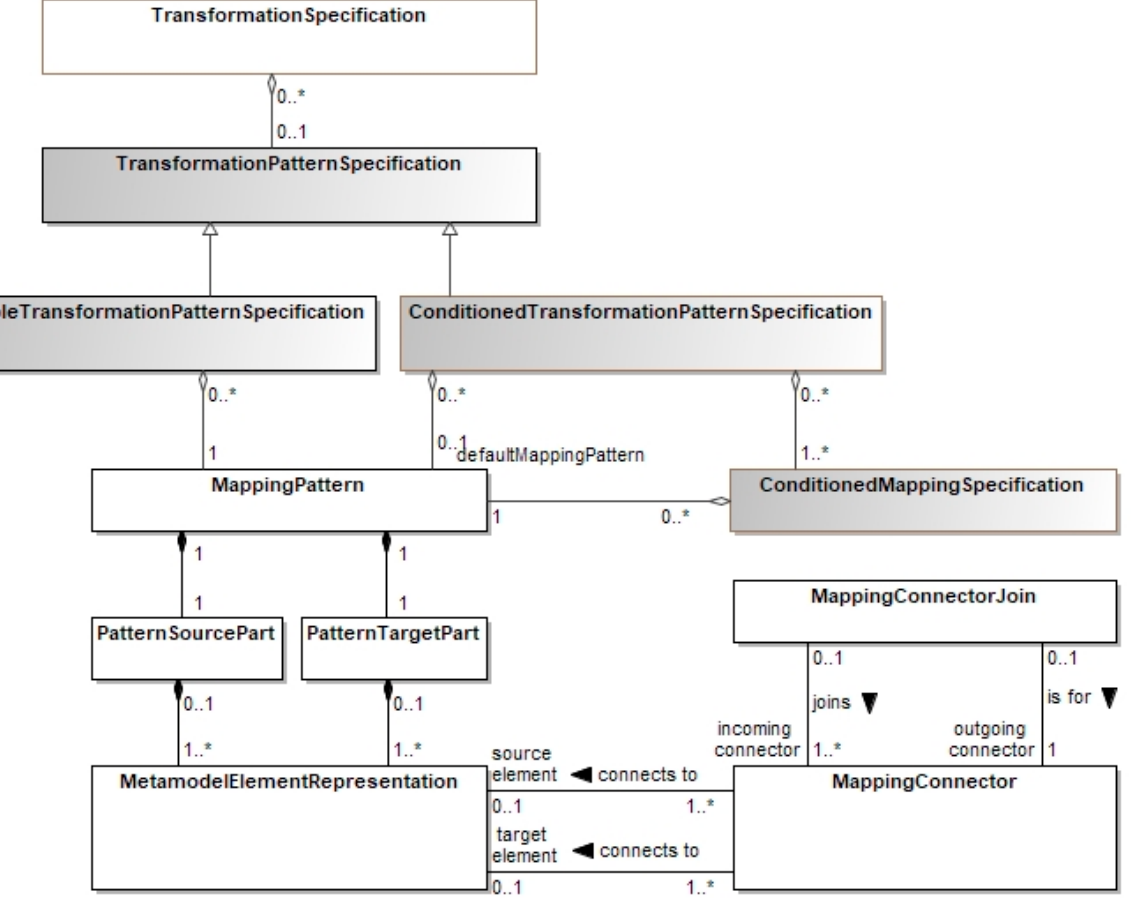
Figure 2. Extended metamodel of model-based M2M transformation.